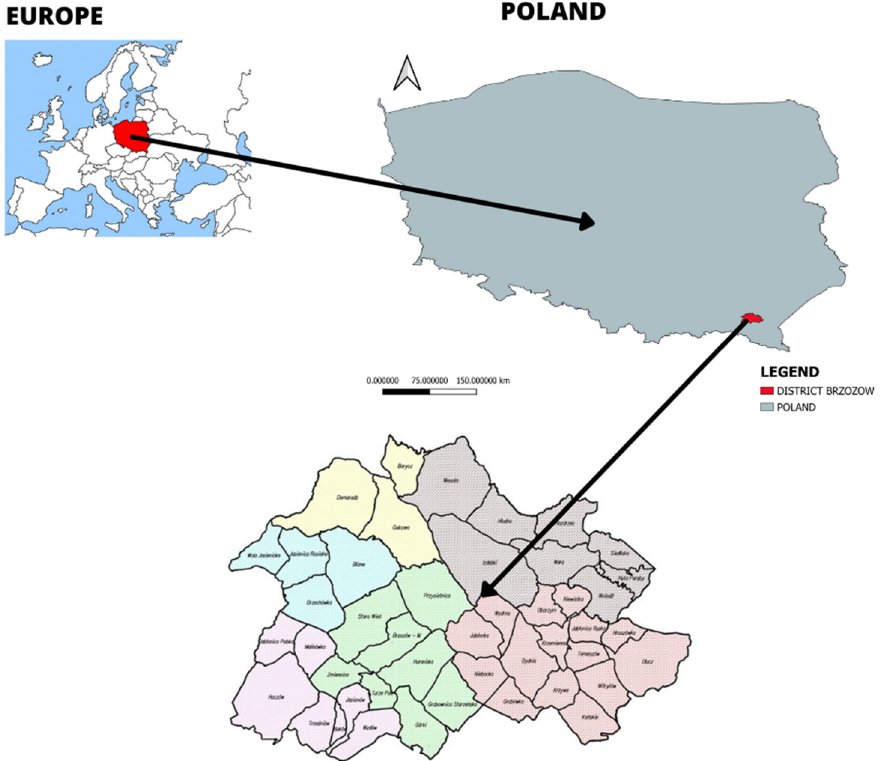
Figure 1. Map of location of the analysed area, in the region and in Europe. The study area covered 44 precincts with an area totalling 53941.00 ha, divided into 144,610 administrative plots owned by individual farmers. The study made use of 24 in- dicators describing land-use categories. Table 1 presents the distribution of respective in- dicators in the whole analysed group. Table 1. The distribution of land-use categories in the Brzozów district.